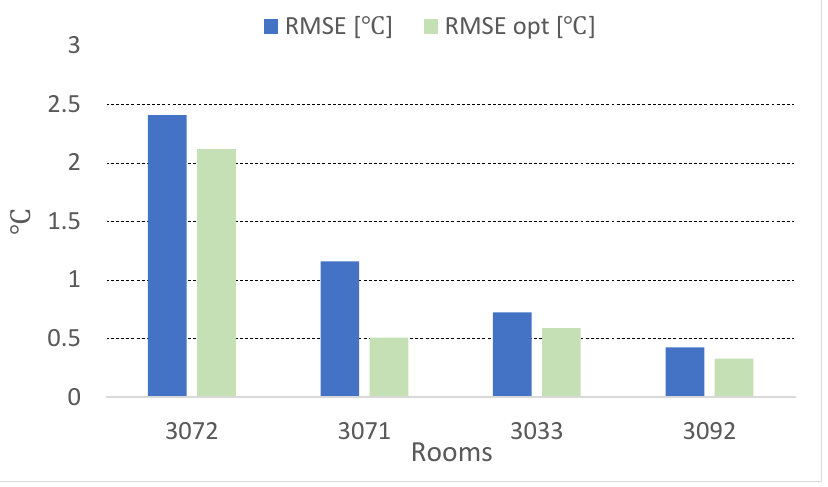
Figure 14. Root-mean-square error for the air temperature: comparison calibrated model vs. opti-